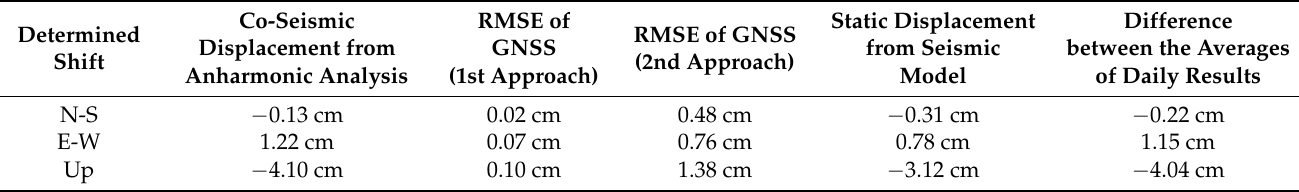
Table 1. Co-seismic displacement of the EYPA station position, as determined by GNSS observations (using the anharmonic spectral analysis) with RMSE from both approaches and the comparison with the static displacement calculated from the COULOMB 3.1 seismic model [13], with the difference between the averages of the daily GNSS results.